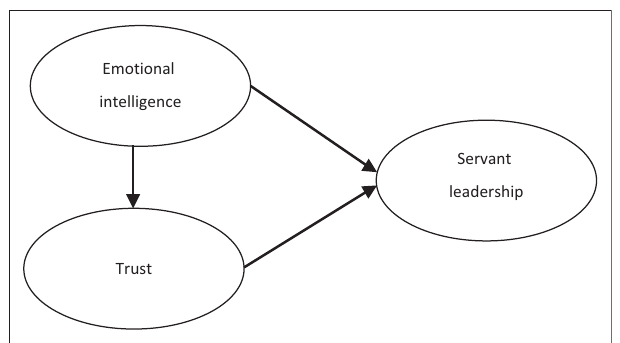
FIGURE 1: Theoretical framework of the relationship between emotional intelligence, trust and servant